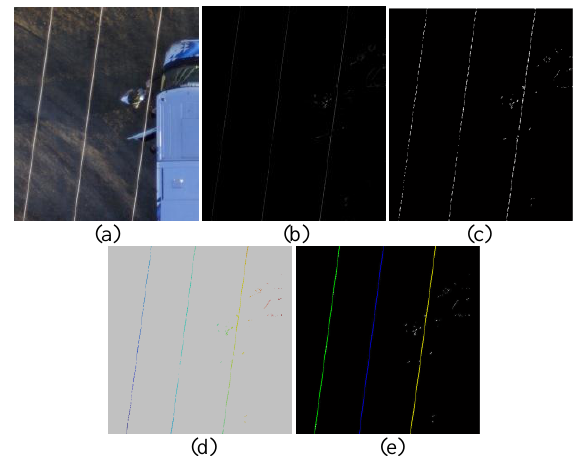
Figure 3. Linear feature detection result. (a) original image; (b) ridge points; (c)-(d) connected components and their colour representation; (e) detected power lines